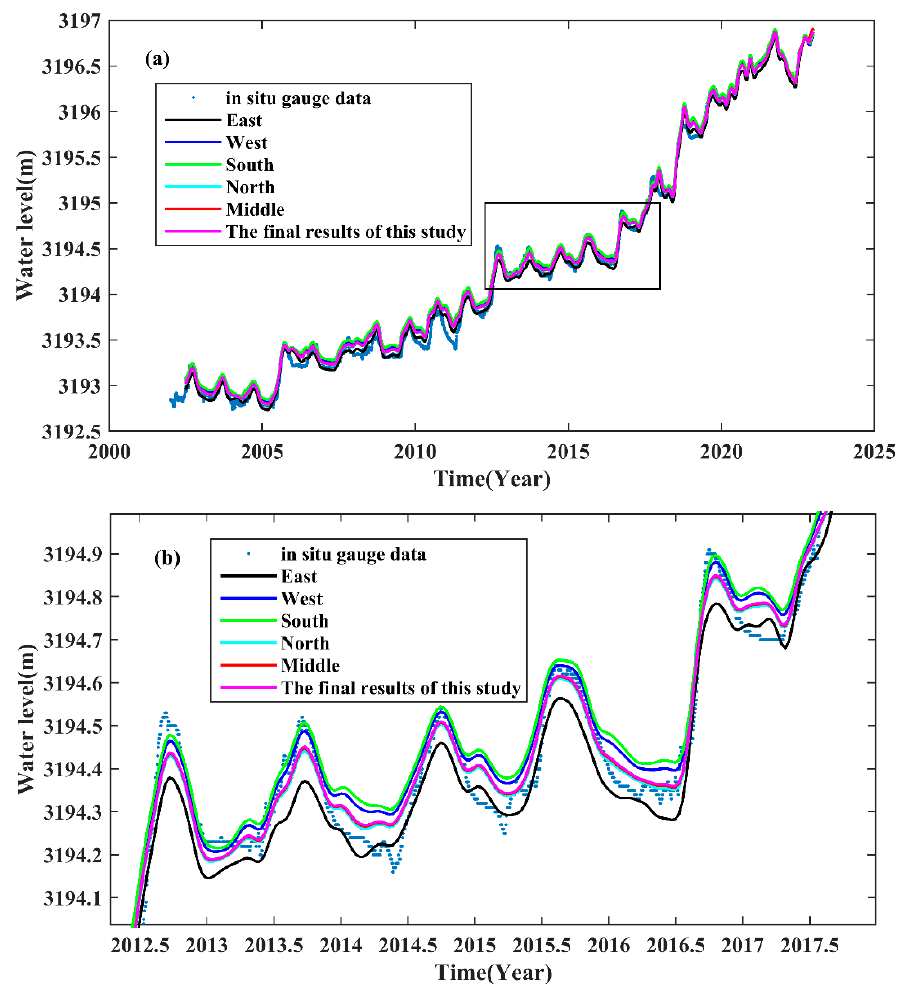
Figure 10. Comparison between the results calculated in this paper and the data from hydrological stations. Under station ( a ) is all the data from 2002 to 2023; ( b ) depicts the part in the box in ( a ).